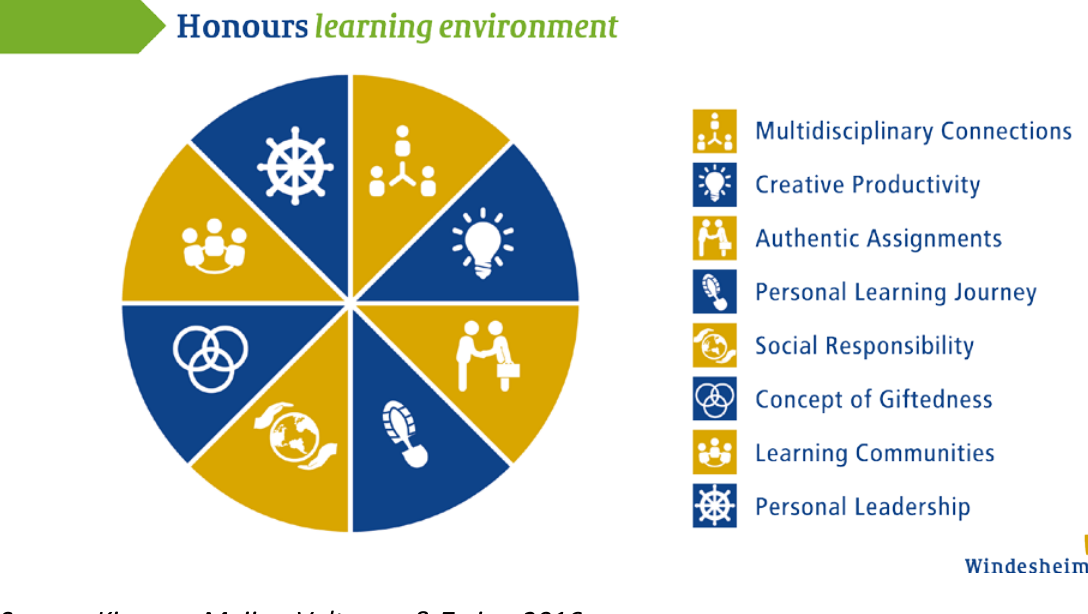
Source: Kingma, Meijer, Veltman, & Zwier,